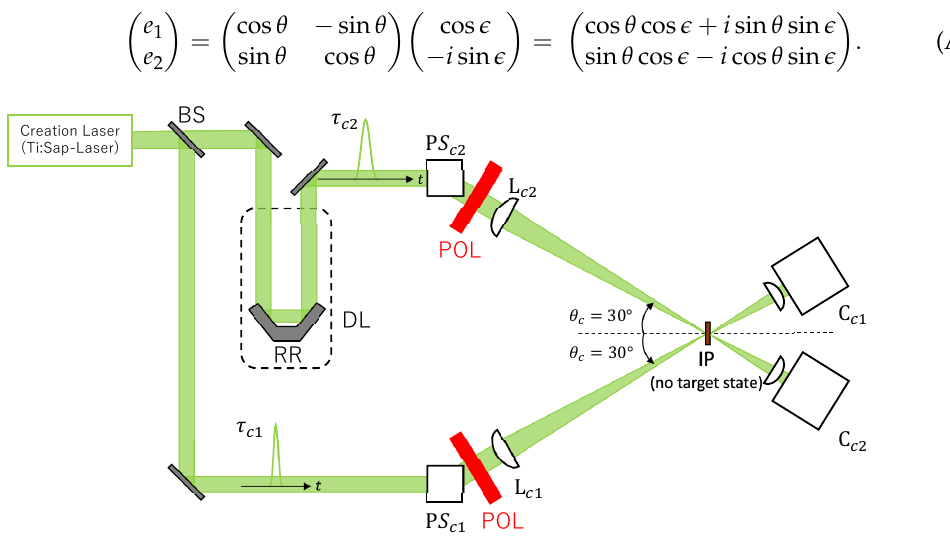
Figure A1. Schematic view of the setup to evaluate two angle parameters to define Jones vectors for the two creation lasers based on Stokes parameters. A polarizer (POL) was placed between a periscope (PS) and a lens (L) in each beamline. Stokes parameters were obtained by measuring transmitted laser intensity through POL at four different rotation angles by using individual cameras C c 1 and C c 2 assigned for the two creation